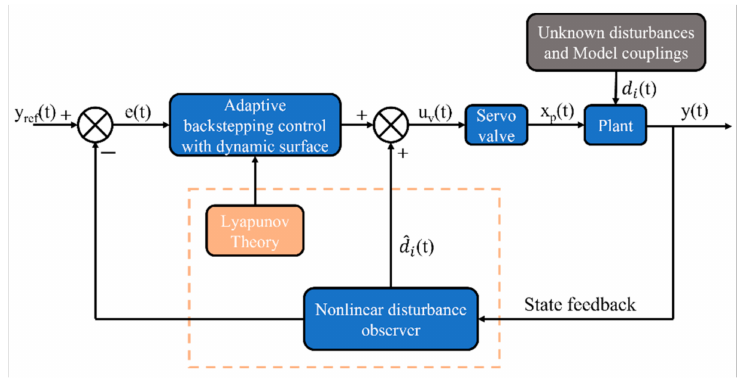
Figure 4. Control